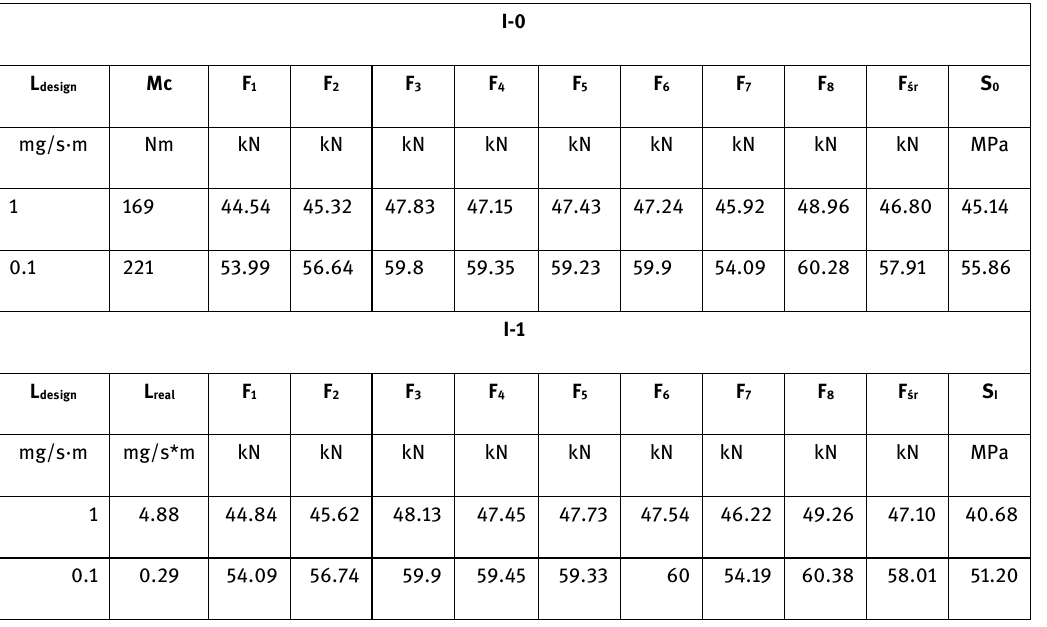
Table 6: Listing of measurement and target data in the form of tightening torque of nuts, tightness class and bolt forces for joint gasketed FG_1 material.